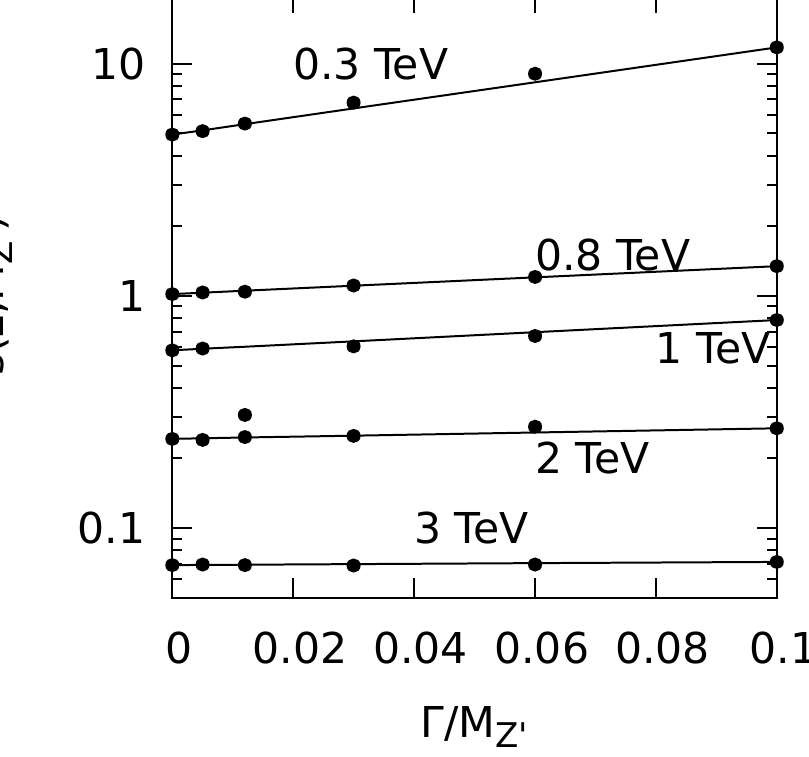
Figure 2 . Examples of the (cid:12)t in eq. (3.1) (shown by lines) compared to ATLAS data (shown by points), for various values of M Z 0 , shown as a label by each